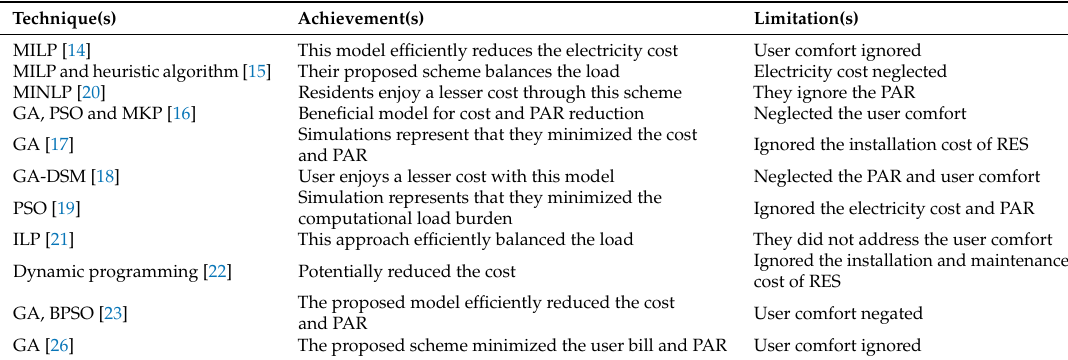
Table 1. Summary of related